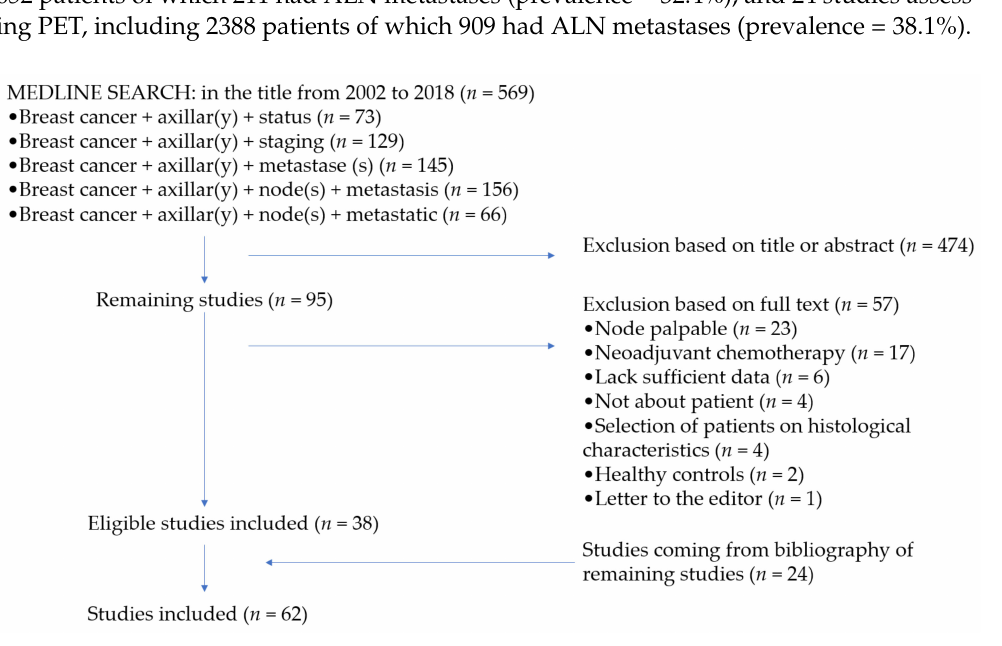
Figure 1. Flowchart depicting the inclusion and exclusion of the identified